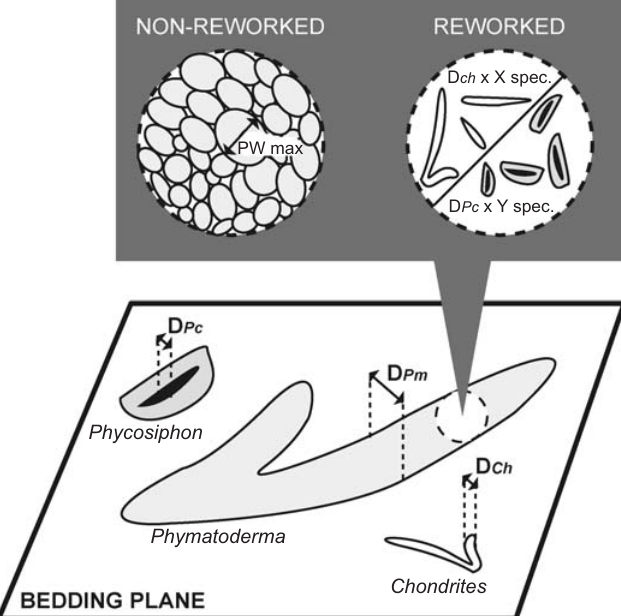
Fig. 4. Schematic diagram showing the measured parameters. D , burrow Ch diameter of Chondrites ; D , burrow (i.e., central core) diameter of Phyco- Pc siphon ; D , burrow diameter of Phymatoderma ; PW , maximum pellet Pm max width; X and Y are the numbers of measured specimens, X ranges from 4–10, Y from